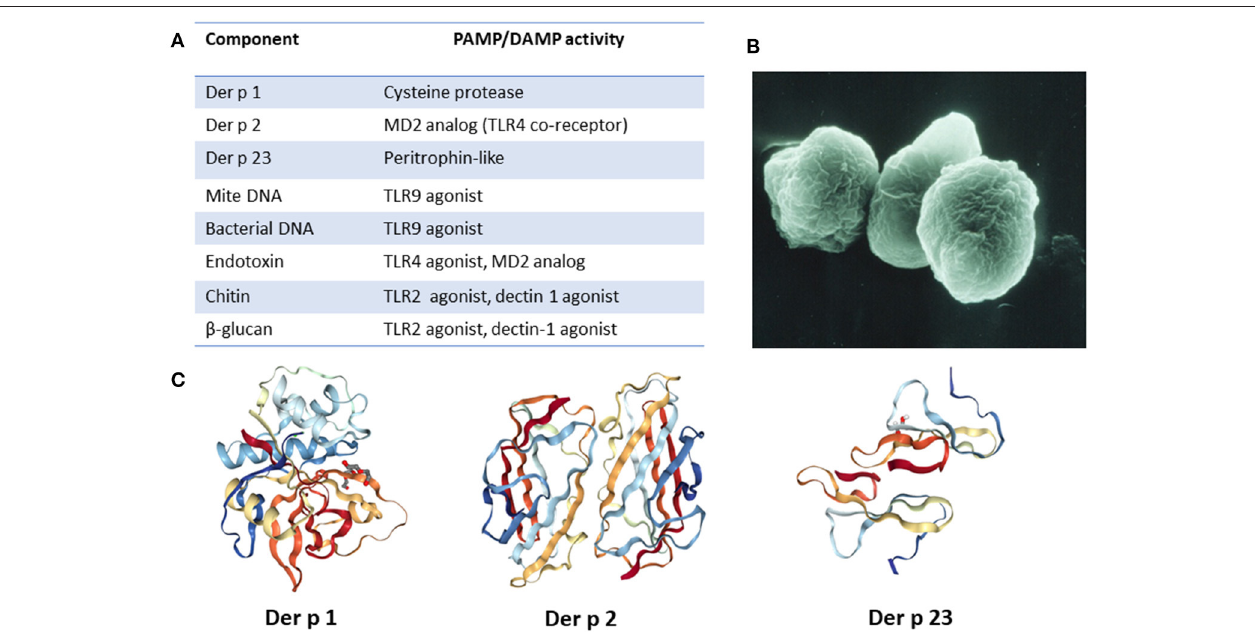
FIGURE 1 | Major HDM allergens and associated constituents present in fecal particles. (A) List of relevant allergens and molecules and their PAMP/DAMP activity. (B) Image of fecal particle (image courtesy of Euan Tovey). (C) Molecular structure of major HDM allergens. Images created with the PDB ID and associated publication, NGL Viewer ( 16), and RCSB